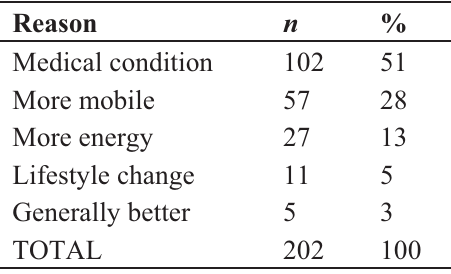
Table 12. Number and percentage of reasons given by patients for feeling their health had improved.